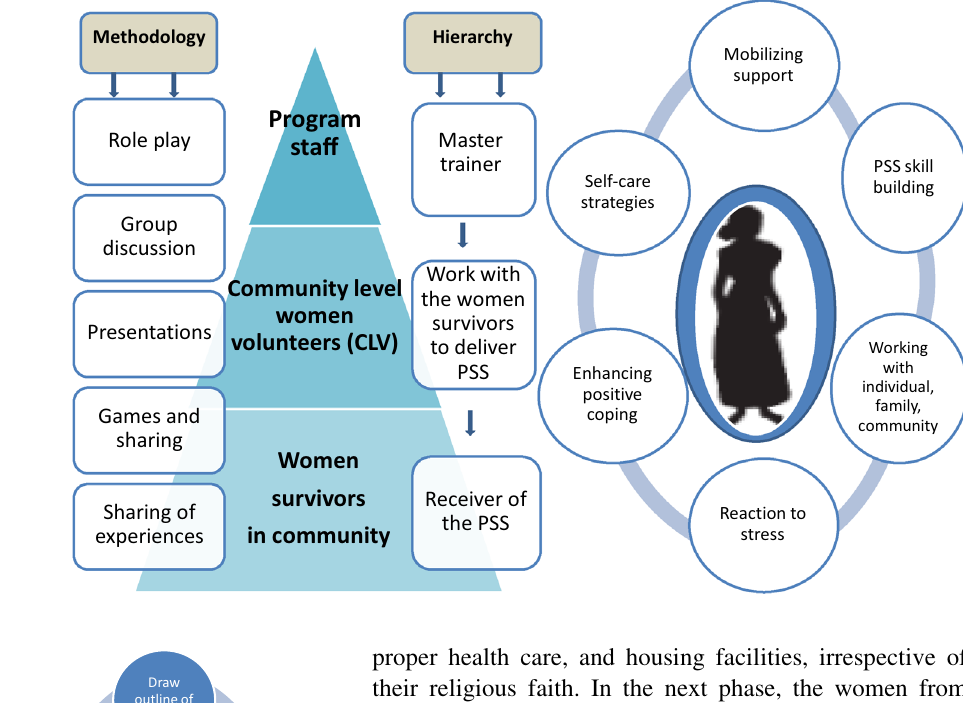
Fig. 1 Community-based